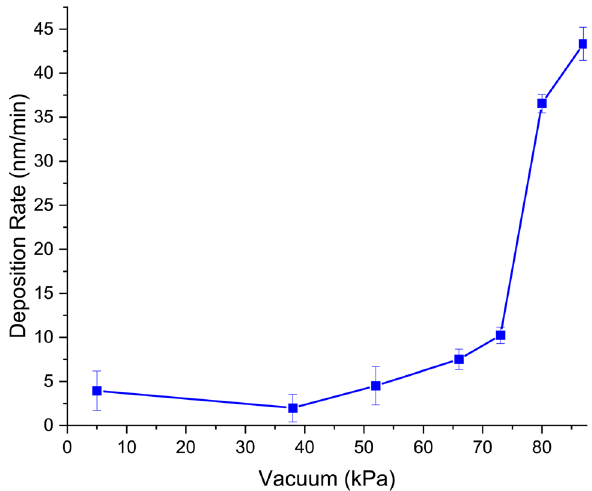
Figure 2. The measured deposition rate of PFTCS depending on vacuum level. All experiments measurements were done after 30 min of deposition and in triplicate. The sharp increase at 73 kPa is due to the vapor pressure of PFTCS and deposition at lower vacuum levels is primarily due to the volatility of the